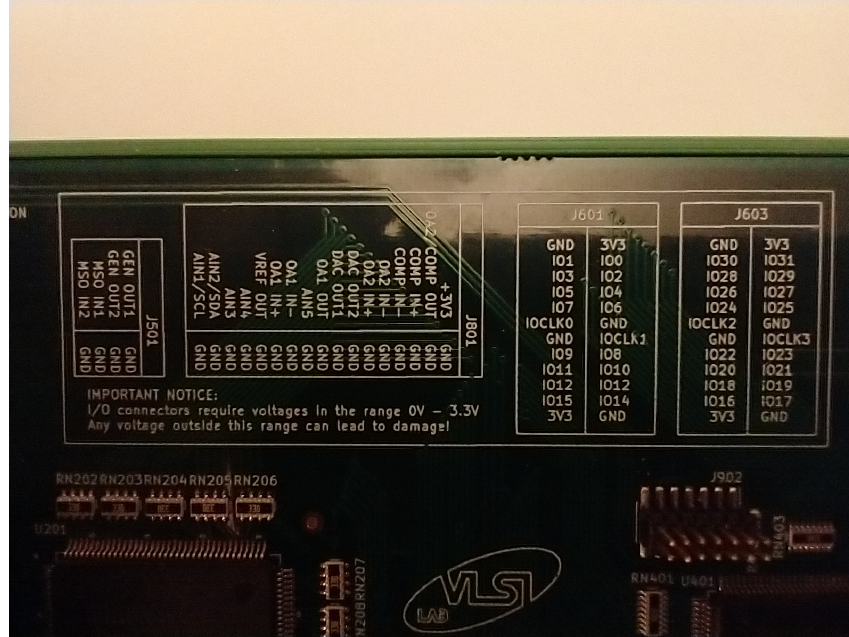
Figure 8. Legend of external I/O